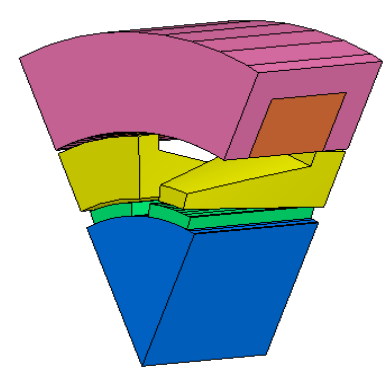
Figure 10. 3D BDRM model.